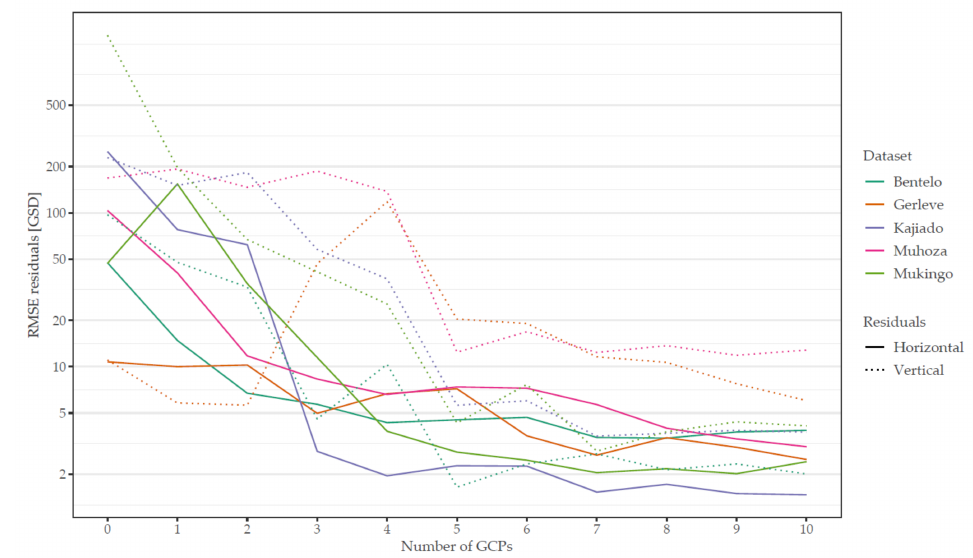
Figure 7. RMSE of checkpoint residuals measured in the DSM (vertical) and orthophoto